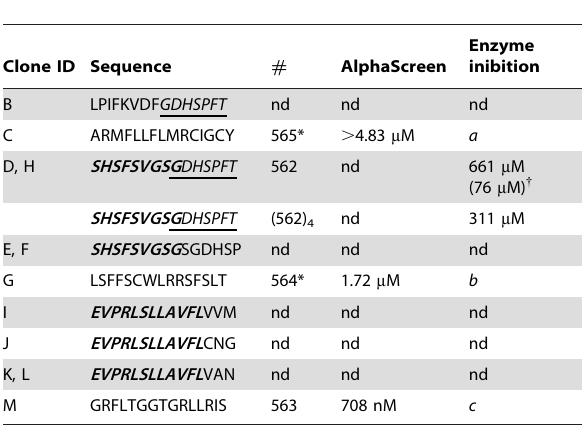
Table 1. Sequences of phage clones isolated after 3-round of panning and IC 50 values of the peptides